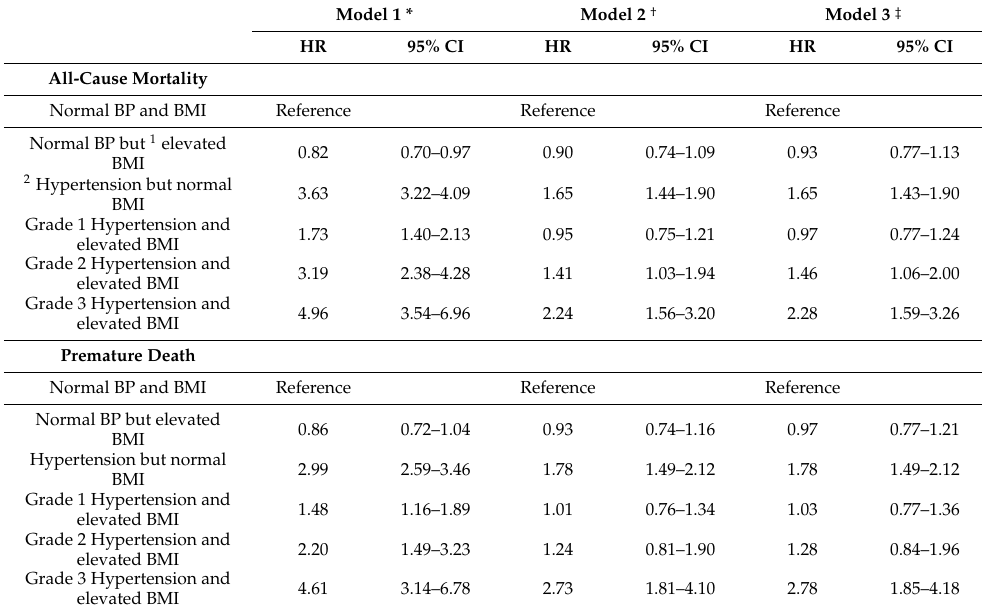
Table 3. Hazard ratios of all-cause mortality and premature mortality according to BMI and blood pressure categories. Model 1 * Model 2